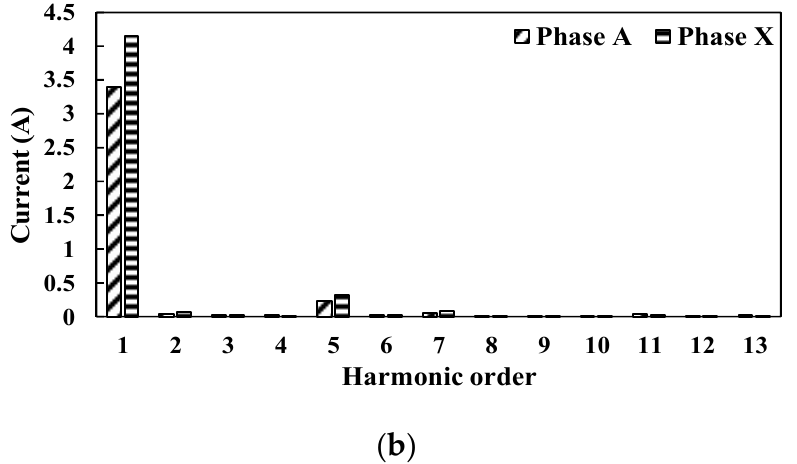
Figure 7. Experimental results with conventional VSD, ( a ) currents: Channel 1: phase of A, Channel 2: phase of X (2A/div), Horizontal: Time (0.02 s/div); ( b ) corresponding harmonics analysis. (PS: “停止” means stop, “噪声滤波器” means Noise Filter).